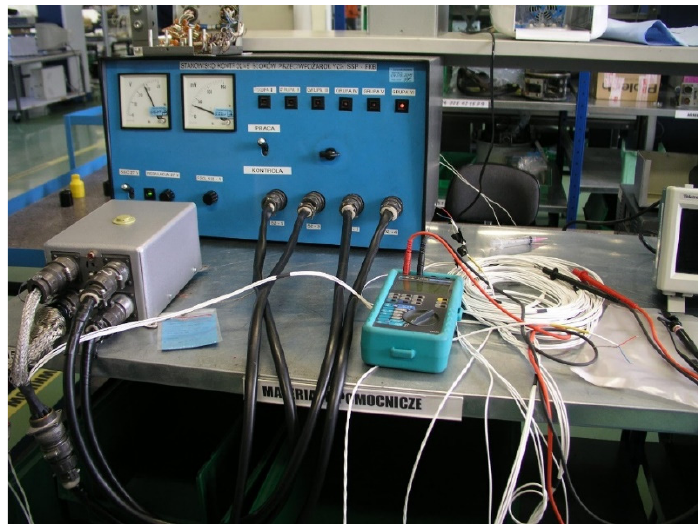
Figure 7. Test bench WZL-1 for checking the correct operation of the SSP − FK − BI executive block s.2. on the “CONTROL” (in Polish “KONTROLA”) range.